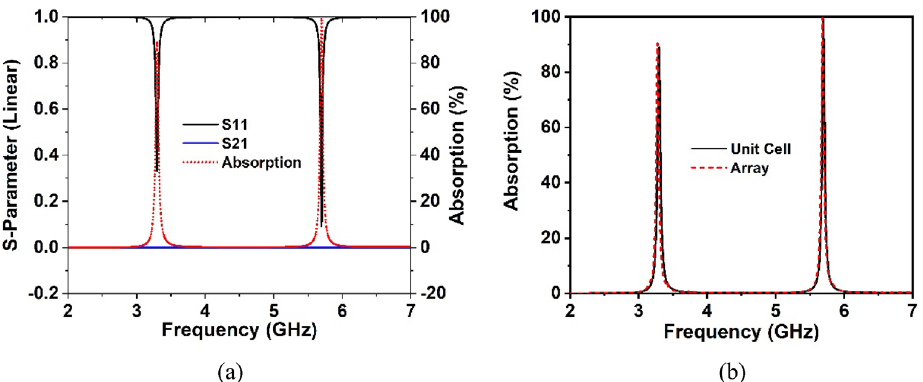
Figure 17. ( a ) Absorption and scattering parameters of the suggested unit cell and ( b ) unit cell and array absorption